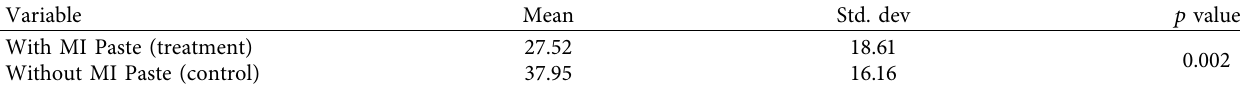
Table 2: Mean (SD) visual analogue scale sensitivity scores of 14 days for treatment and control arches.